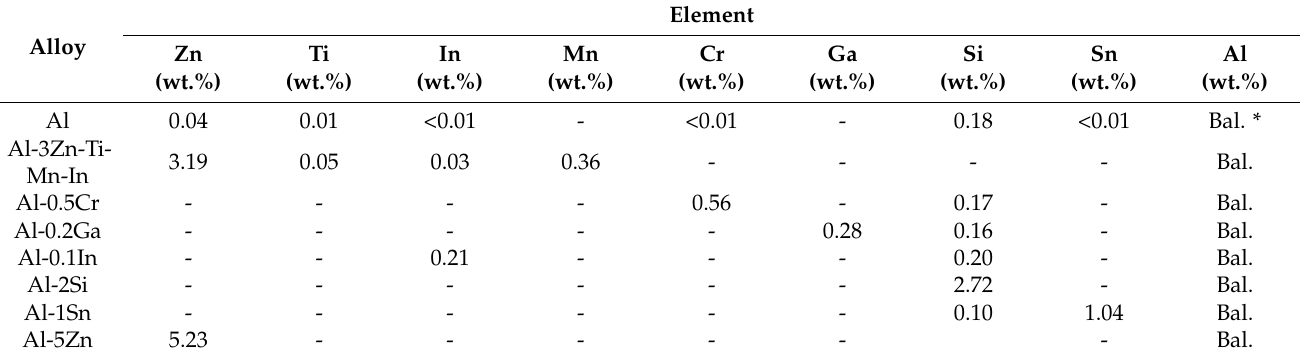
Table 2. Chemical composition of binary Al-based alloys determined by X-ray